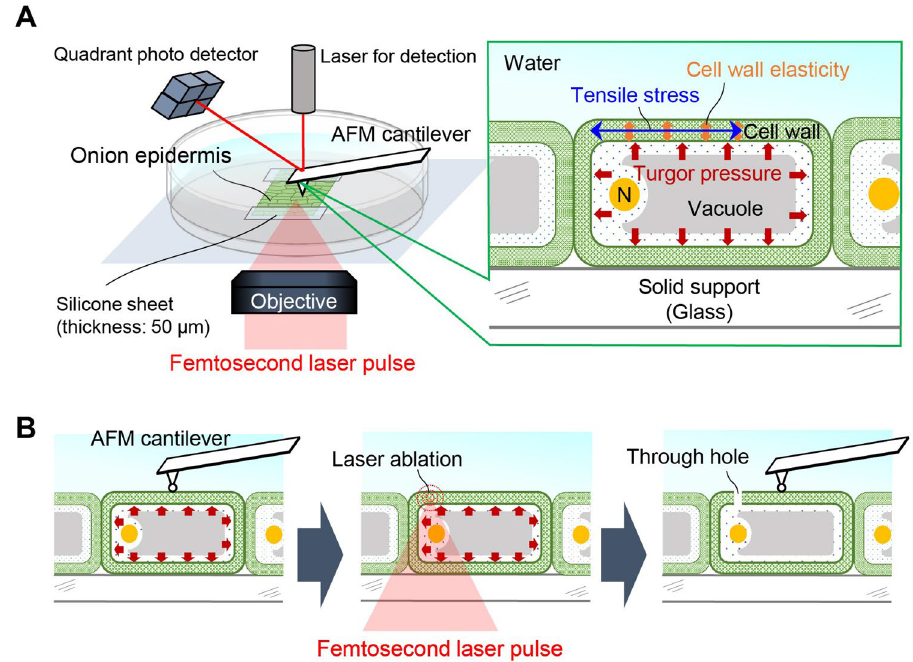
Figure 1. Schematic illustration of laser-assisted AFM measurement of the onion epidermal cell wall. ( A ) Experimental setup of AFM with laser perforation. ( B ) Experimental procedure of AFM detection and perforation using femtosecond laser pulse irradiation to make a through